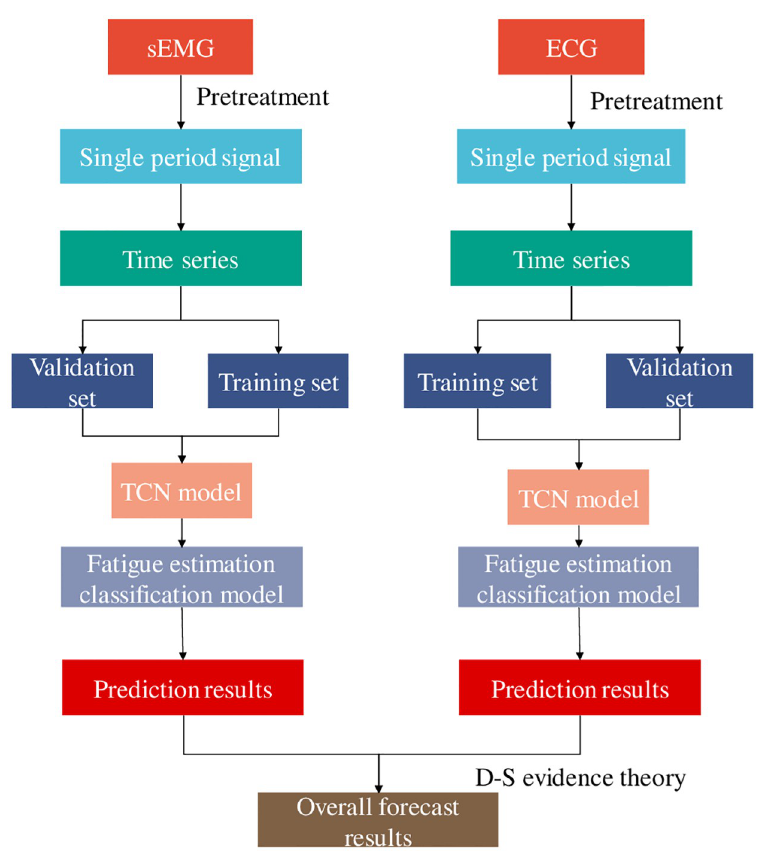
Fig 7. Fatigue evaluation model flow based on TCN and data